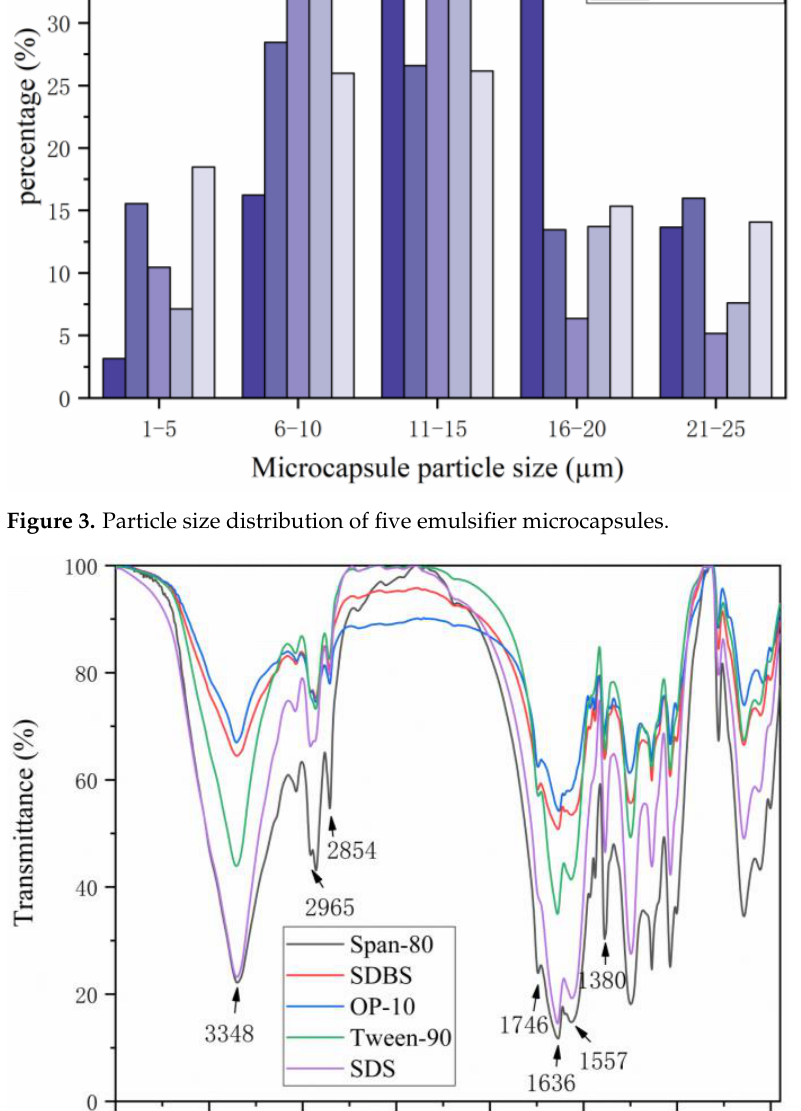
Figure 3. Particle size distribution of five emulsifier microcapsules.